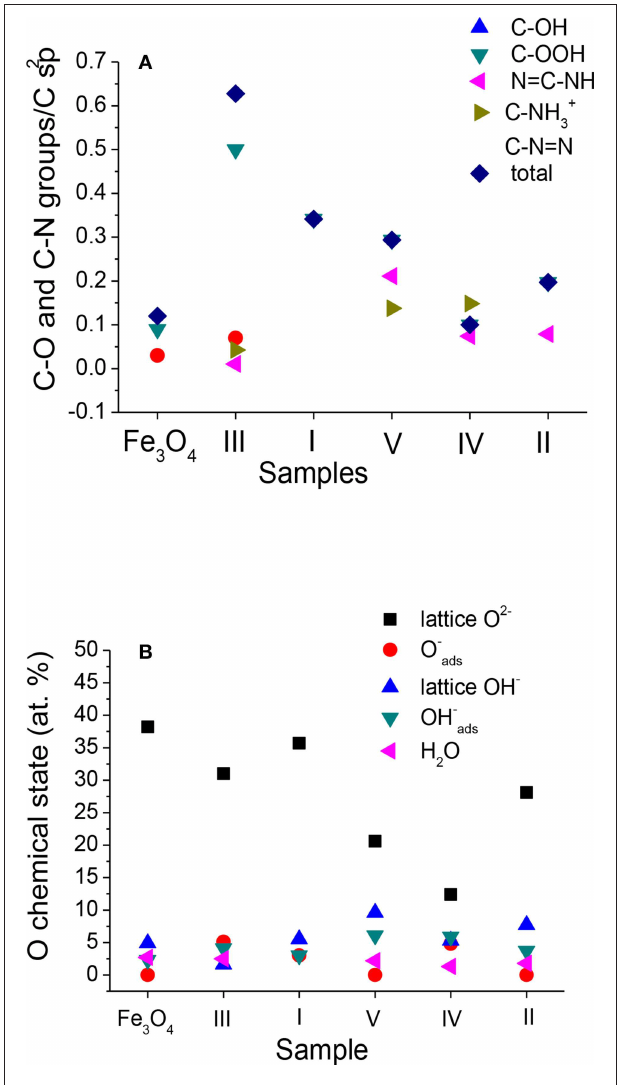
FIGURE 5 | Contents of (A) carbon–oxygen and carbon–nitrogen groups resulting from fitting of C 1s spectra normalized to C sp 2 and (B) oxygen chemical states resulting from fitting of O 1s spectra in Fe 3 O 4 MNPs and Fe 3 O 4 f-MNPs I–V. Sample f-MNPs I–V are listed in the order of decreasing